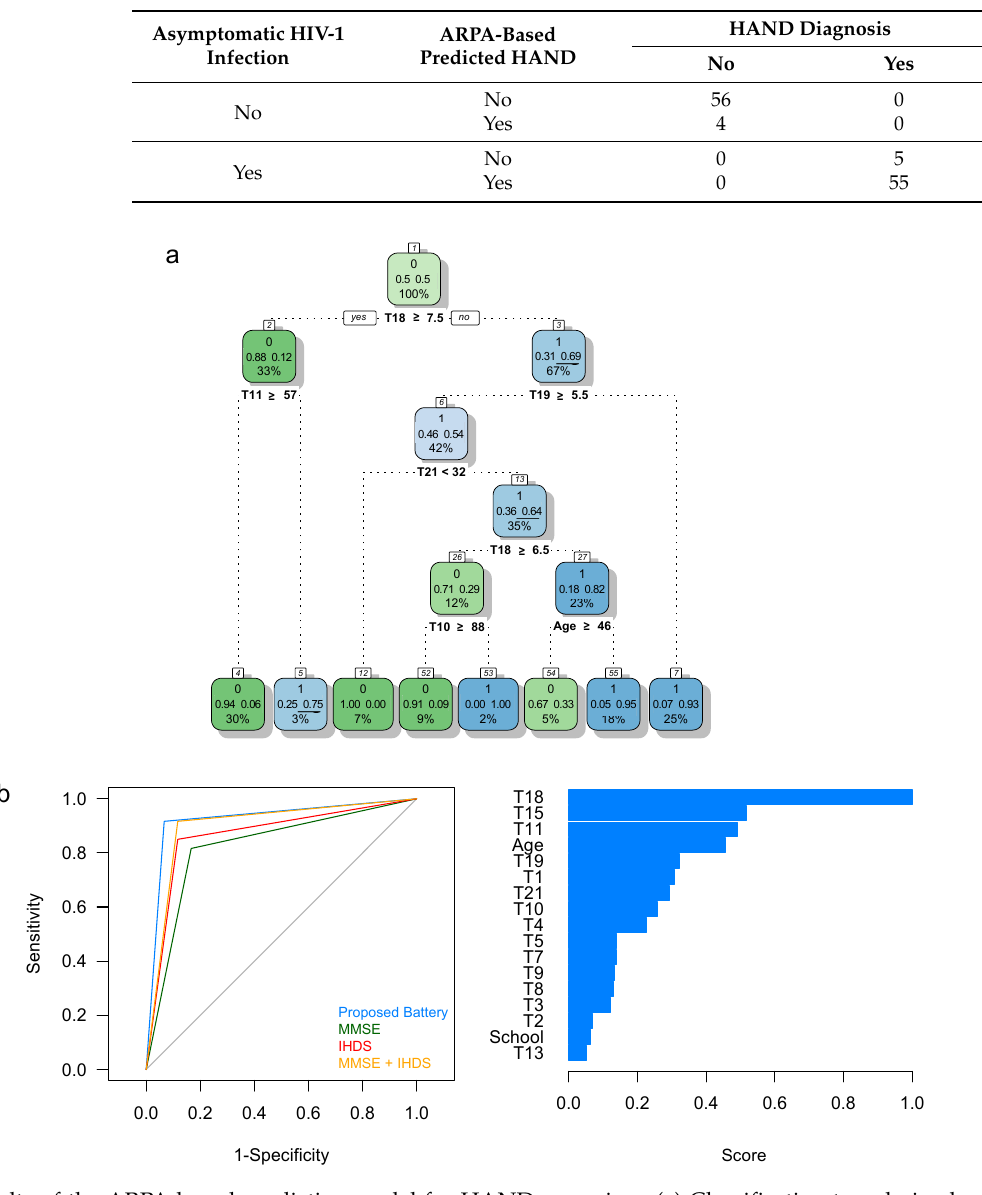
Figure 1. Results of the ARPA-based predictive model for HAND screening. ( a ) Classification tree derived using the CART strategy. HAND status was defined using 1 S.D. below the normative data and predicted using the proposed neuropsychological battery. Numbers within white squares represent the node number; the first line corresponds to the most frequent class (0: Unaffected; 1: HAND affected), the second line to the probability of each class within the node, and the third line to the percentage of the total sample size ( n = 120) within each node. Nodes where HAND-affected individuals are more likely to be classified are shown in blue. ( b ) ( left ) ROC curves when HAND status was predicted using the ARPA-based model, including the proposed battery, MMSE, IHDS, and both MMSE and IHDS. ( right ) Variable importance for the derived predictive model based on the proposed battery. ARPA: Advanced recursive partitioning approach; CART: Classification and regression tree; ROC: Receiver operating characteristic. School: Years of education. Here, T1, T2, . . . , T21 correspond to the neuropsychological and psychological tests. See Table 2 for more